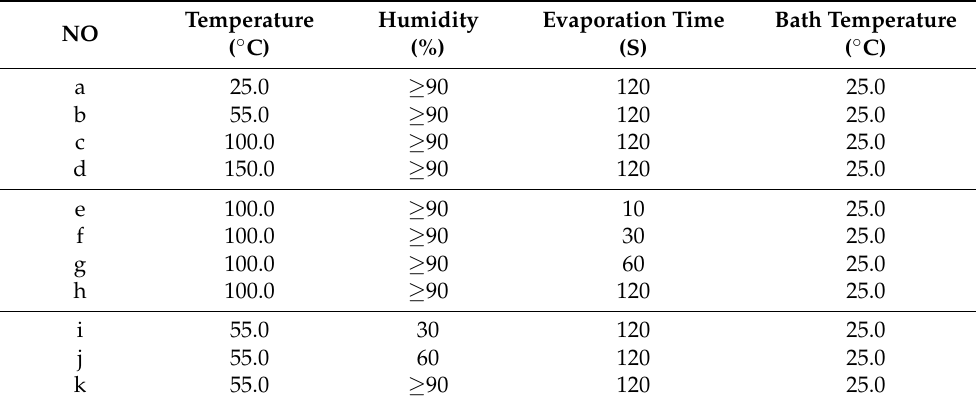
Table 2. Preparation conditions of separation